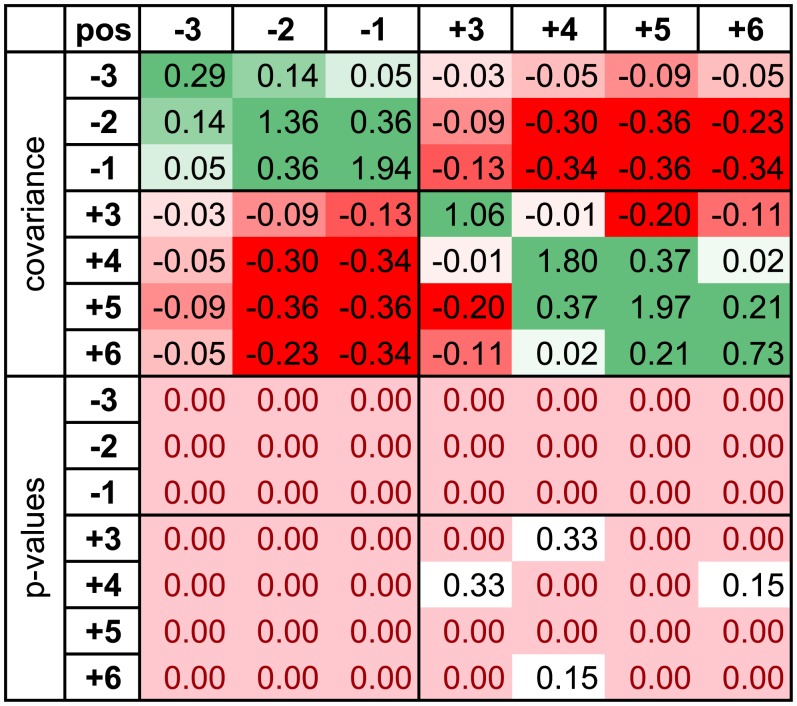
Covariance matrix of strength vectors for constitutive-exon DSSs (M. musculus).Top, covariance matrix, with positive covariance values in green, negative values in red, and color depth depending on the absolute value. Bottom, p-values that the given covariance is significantly different from zero obtained from bootstrapping; p-values < 0.05 are in pink.